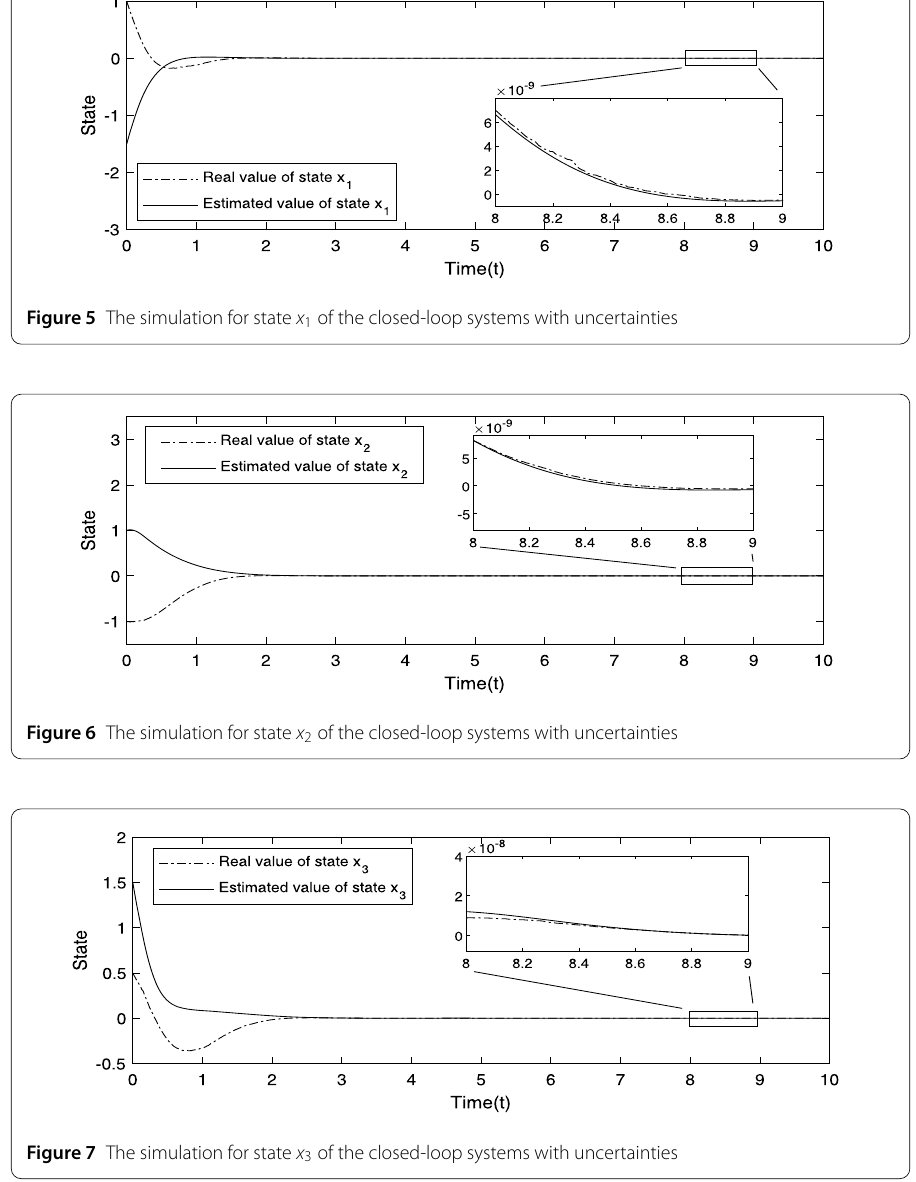
istence of the observer are given. Also, the desired gain matrix and state-feedback con- troller are constructed by solving certain LMIs, which can be implemented by using the LMI control toolbox. Moreover, one can readily obtain the delay-dependent results on the existence of an observer for the uncertain stochastic time-delay system. The numerical ex- ample has demonstrated the effectiveness of the proposed